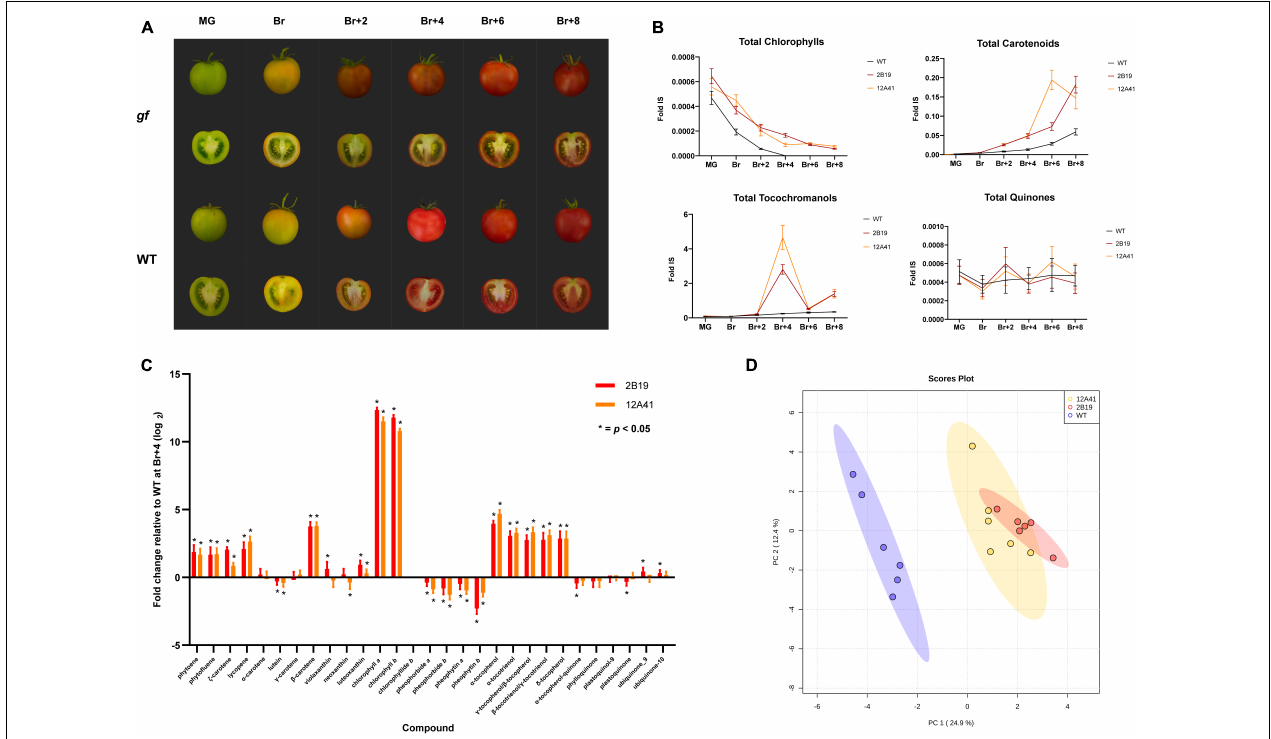
FIGURE 4 | LC-MS analysis of the isoprenoid composition of two isogenic gf ‘MoneyMaker’ lines. (A) Fruit phenotype during ripening. gf and wild-type ‘MoneyMaker’ fruits at six ripening stages: mature green (MG), breaker (Br), and 2, 4, 6, and 8 days after breaker (Br+2 to Br+8). (B) Abundance of different isoprenoid classes during ripening. The accumulation trend of four classes of isoprenoid compounds (chlorophylls, carotenoids, tocochromanols, and quinones) was monitored across six ripening stages (MG to Br+8). The abundance of each compound is expressed relative to the internal standard (Fold IS). (C) Metabolite composition at Br+4. Relative abundance of a total of 29 isoprenoid compounds in edited gf fruits compared to the wild-type, 4 days after breaker. Asterisks signal significant differences between mutant and WT (Student’s t -test, p < 0.5). (D) Principal Component Analysis (PCA) of the metabolite composition of WT and gf fruits at